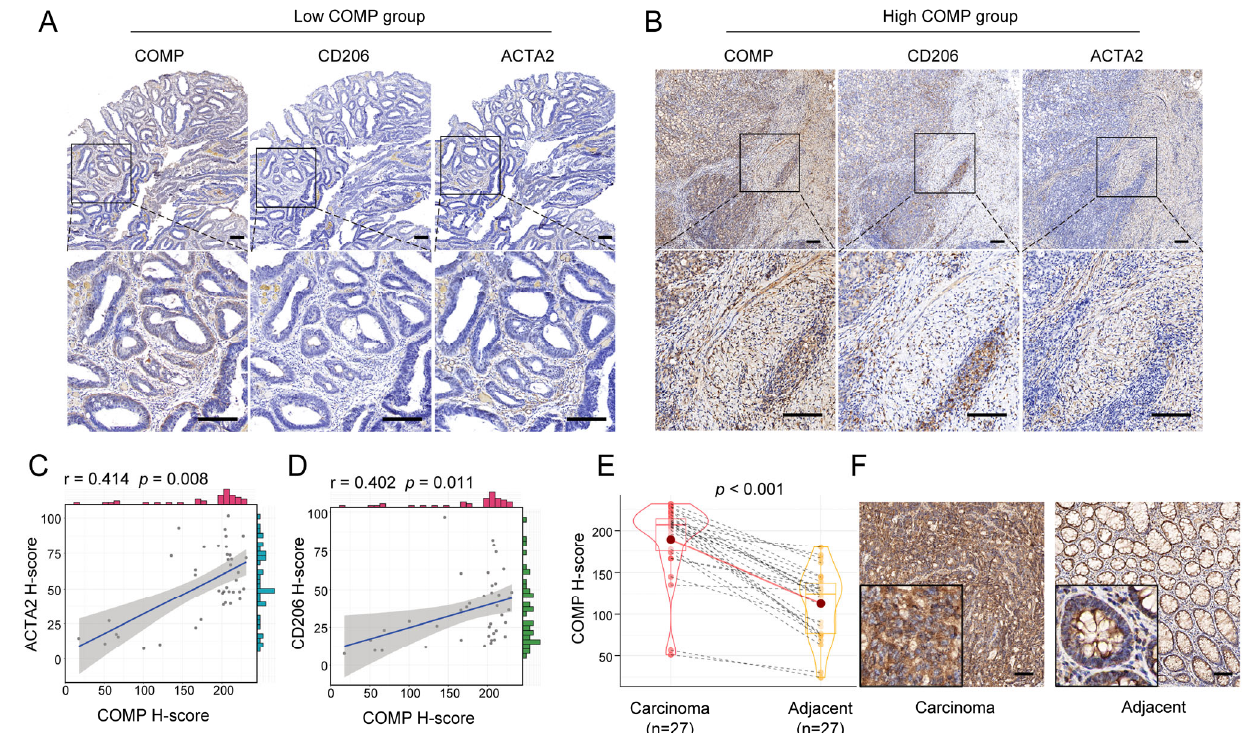
Figure 8. Verification of the correlation between COMP expression and infiltration levels of CAFs and M2 macrophages in colon cancer specimens. ( A,B ) Coexpression analysis of COMP with the CAFs marker ACTA2 and the M2 macrophage marker CD206 using IHC staining in low ‐ and high ‐ COMP expression subgroups; ( C ) Correlation between the expressions of COMP and ACTA2; ( D ) Correlation between the expression of COMP and CD206. ( E,F ) Comparison of COMP expression in primary colon cancer and adjacent normal tissues by IHC staining (scale bar = 100 μ m). Emerging studies reveal that distinct TME characteristics may be associated with dis ‐ tinct prognoses and varying degrees of immunotherapy efficacy [6,7]. Our findings showed that COMP was highly associated with CAF abundance and stromal score, which was fol ‐ lowed by the validation of COMP coexpression with ACTA2 in clinical samples, indicating that COMP expression may partially reflect CAF abundance in colon cancer. It is considered that tumor ‐ associated macrophages can polarize into two major phenotypes: proinflamma ‐ tory M1 and protumorigenic M2 [63]. Our findings revealed that high ‐ COMP subgroup pa ‐ tients were prone to exhibit the M2 phenotype, and IHC results also showed a coexpression of COMP and the M2 macrophages marker. Studies also show that CSF ‐ 1, TGF ‐β , and IL ‐ 10, secreted by CAFs, are required for monocytes to differentiate into M2 ‐ like TAMs [55,56]. Consistently, several chemokines and cytokines that induced the M2 phenotype were shown in our result. These findings imply that the COMP ‐ and other CAFs ‐ released mole ‐ cules, collectively, promoted an M2 immunosuppression phenotype in colon cancer TME, which might contribute to a poor prognosis. Although the immunomodulatory processes in TME are intricate, the cancer immunity cycle is regarded as a thorough representation of the overall effect of these processes [37]. Herein, we found that COMP was favorably connected with the activities of numerous phases in the cancer immune cycle and inversely connected with immunotherapy ‐ related signs. All these results indicate that COMP ‐ induced M2 mac ‐ rophage infiltration impaired the high activity of antitumor immune processes, and the treatment targeting COMP may reverse the M2 immunosuppression phenotype and be in ‐ strumental for immunotherapy in colon cancer patients.